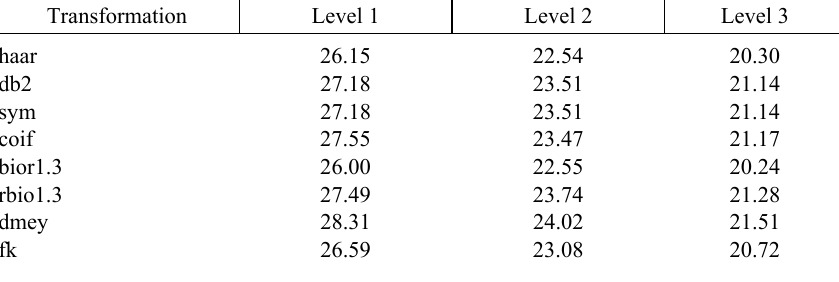
Table 4. PSNR (dB) values for three decomposition levels obtained by applying different wavelet transformations to the original image with HD Transformation Level 1 Level 2 Level 3 haar 23.93